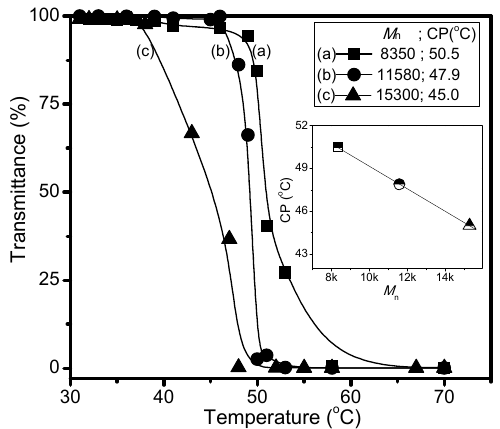
Figure 5. Plot of lower critical solution temperature (LCST) trends of copolymers with different molecular weights (MWs) and linear correlation curve (C 2 NVP mol % in copolymer ≈ 64%; conc. = 1 mg/mL).